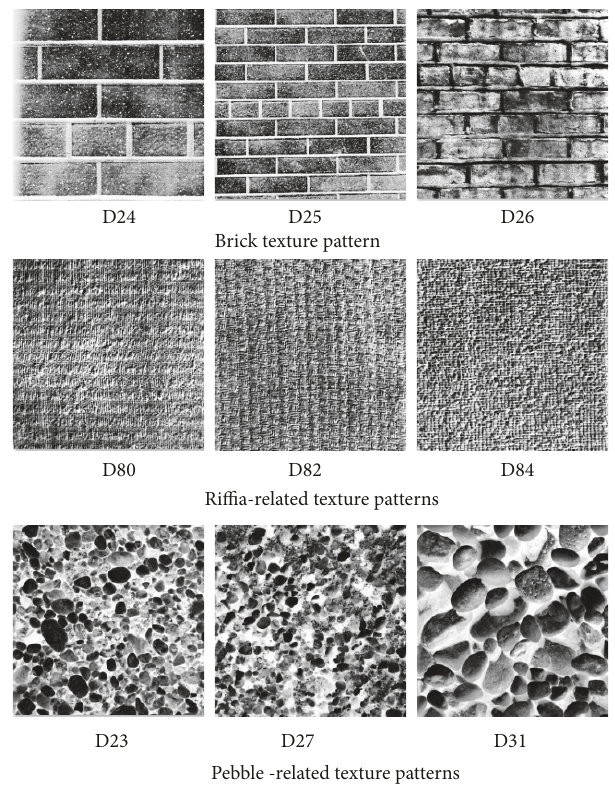
Figure 9: Some confusing texture patterns in B Lc .